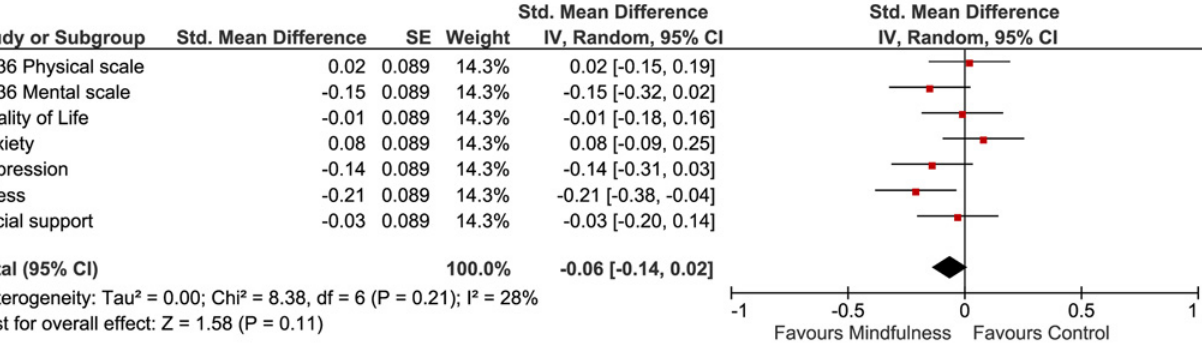
Fig 7. Forest plot showing the As-Treated Cohen ’ s D results of the effectiveness of the mindfulness intervention compared with usual care on the psychological outcomes. The width of the line indicates the 95%CI. All values lower than 0 indicate a significant difference in favour of the mindfulness